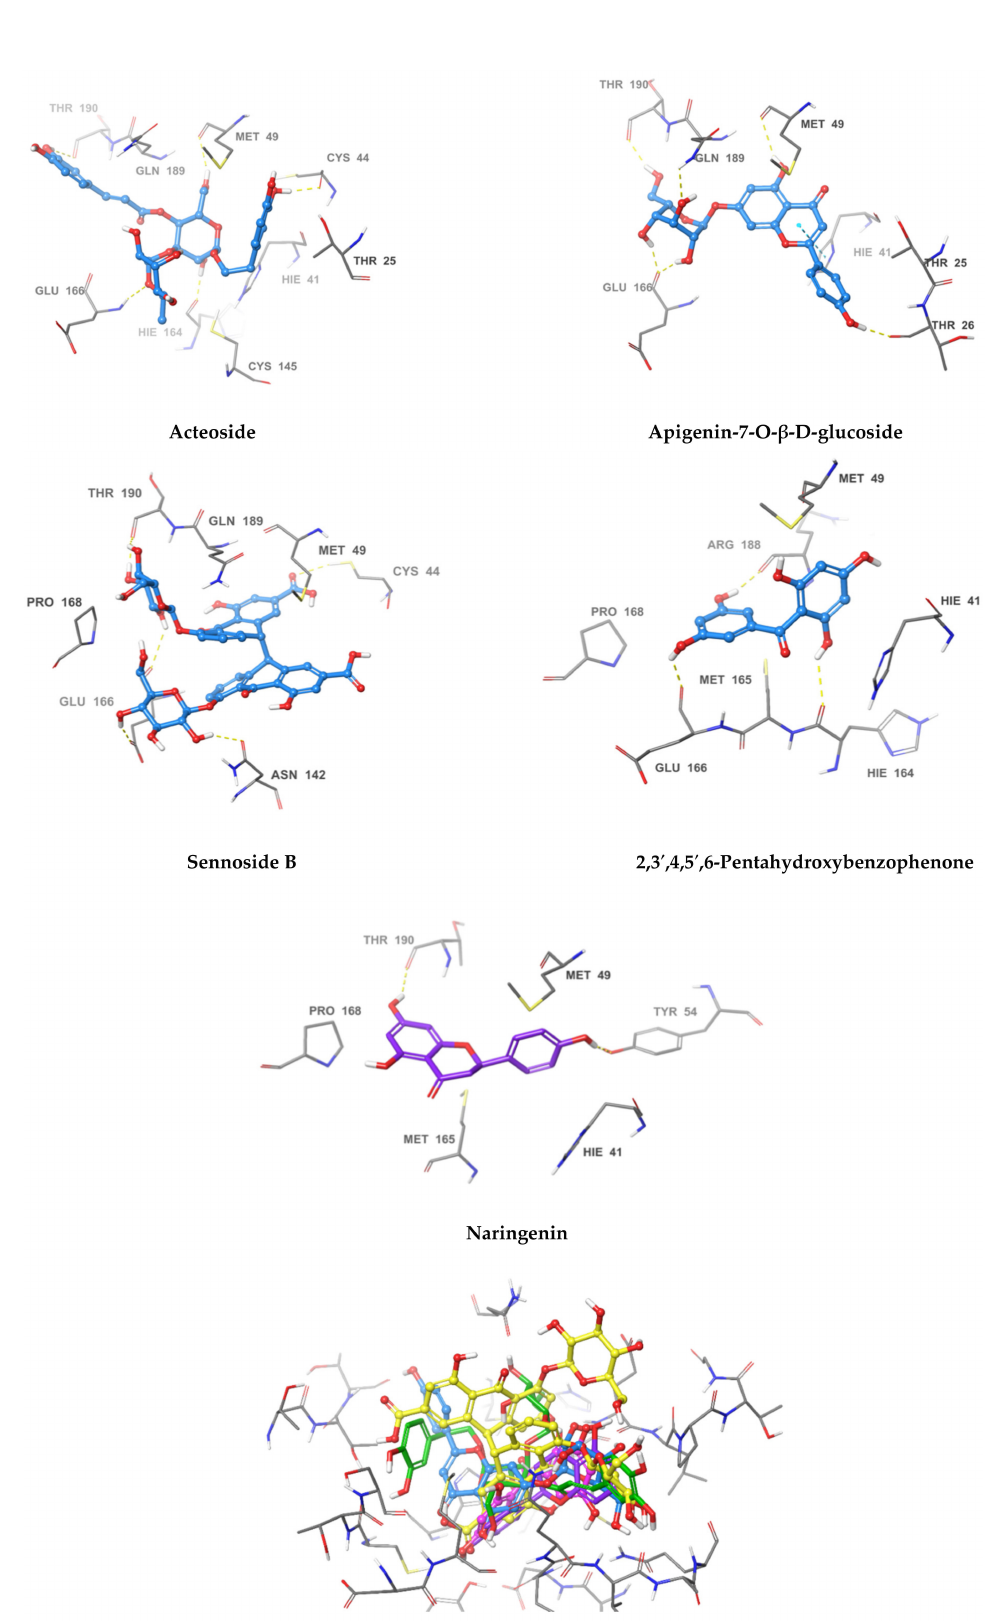
Figure 3. 3D Interaction diagrams of acteoside, apigenin-7-O- β - D -glucoside, sennoside B, 2,3 (cid:48) ,4,5 (cid:48) ,6-pentahydroxy ben- zophenone, and naringenin, respectively. The final image shows an overlay of the docked compounds in the active site of SARS-CoV-2 M PRO . The compounds are colored in green, blue, yellow, magenta and violet